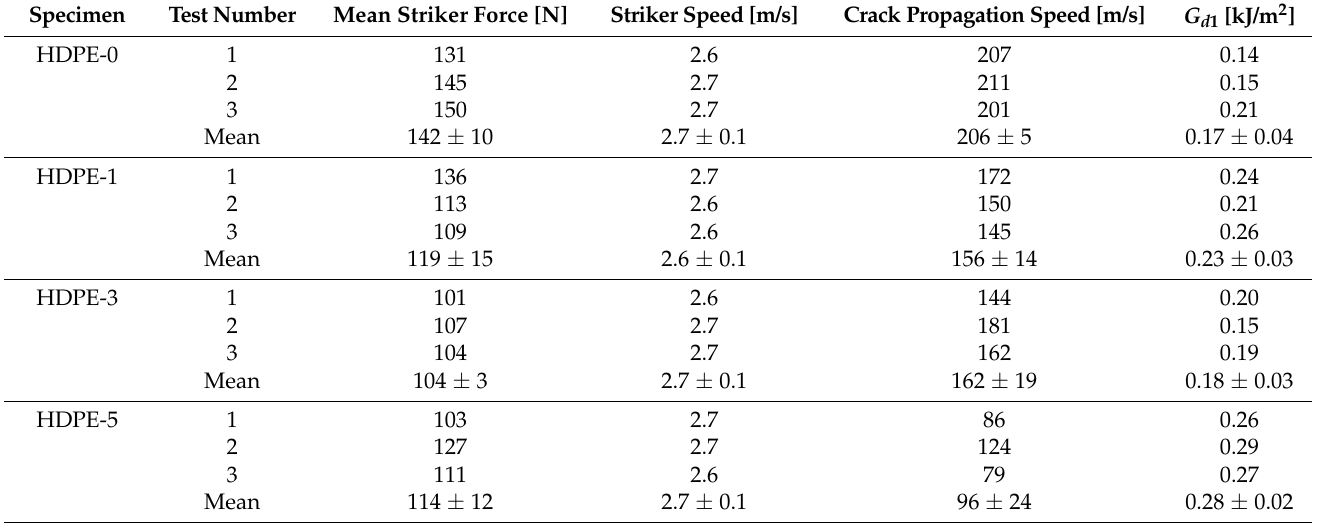
Table 2. HSDT test results for the different HDPE–clay nanocomposites (containing 0, 1, 3, and 5 wt% of nanoclay,